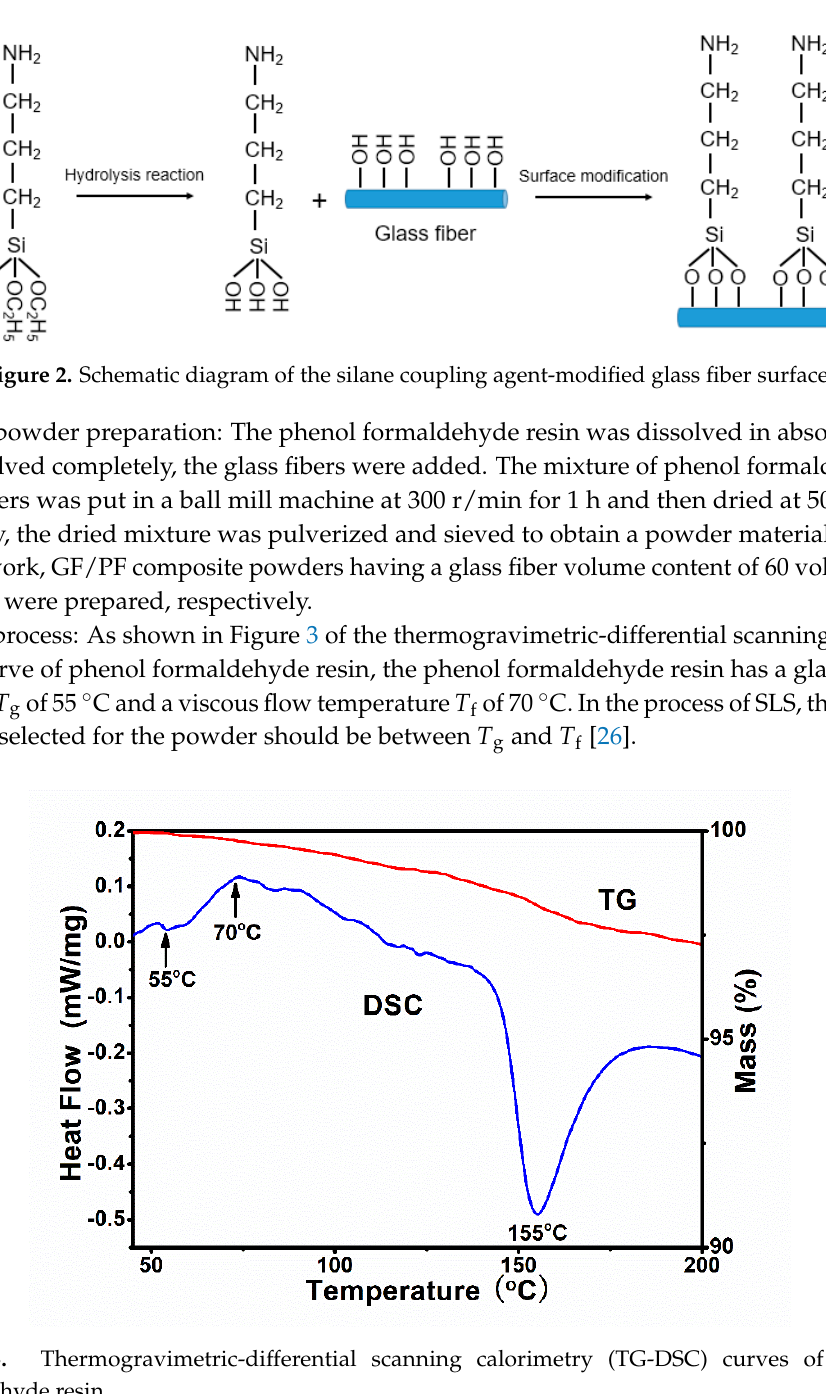
Figure 3. Thermogravimetric-differential scanning calorimetry (TG-DSC) curves of phenol formaldehyde resin.